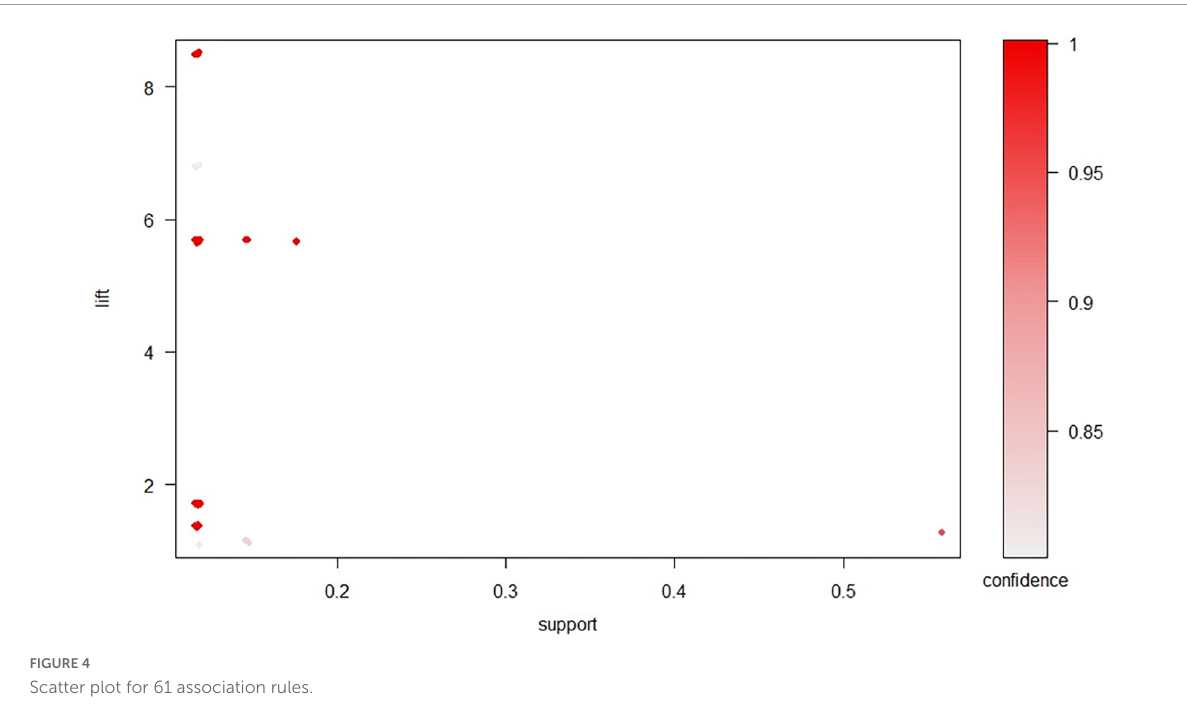
FIGURE4 Scatter plot for 61 association rules.